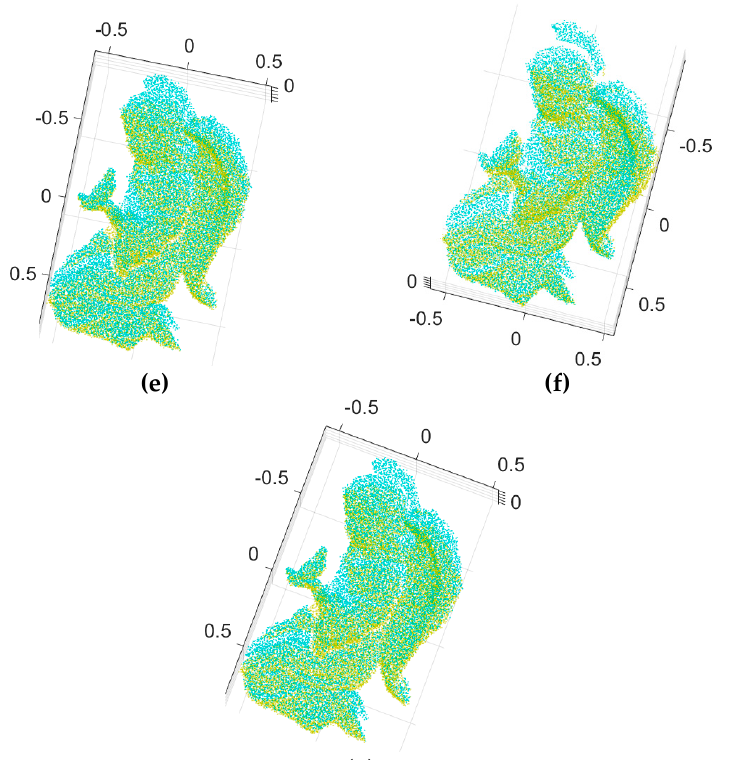
Figure 7. 3D registration results for the proposed method and others: ( a , b ) two input synthetic range images with added Gaussian noise ( σ = 0.0025), ( c – e ) range images aligned by Go-ICP, trimmed Go-ICP, and fast global registration, respectively, ( f ) range images aligned by our branch-and-bound, ( g ) the refined registration result of ( f ) by ICP.